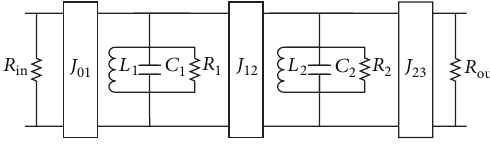
Figure 1: Two-pole lossy filter model.